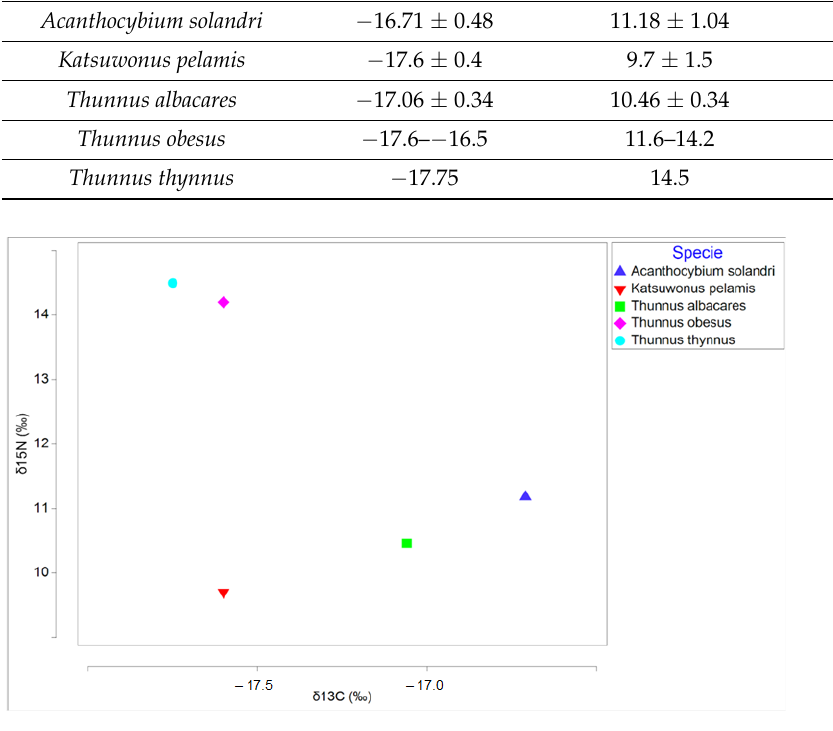
Table 3. Values of δ 13C and δ 15N found in Acanthocybium solandri, Katsuwonus pelamis, Thunnus albacares, Thunnus obesus and Thunnus thynnus collected in the Atlantic Ocean. Results are expressed as mean ± standard deviation or as ranges.